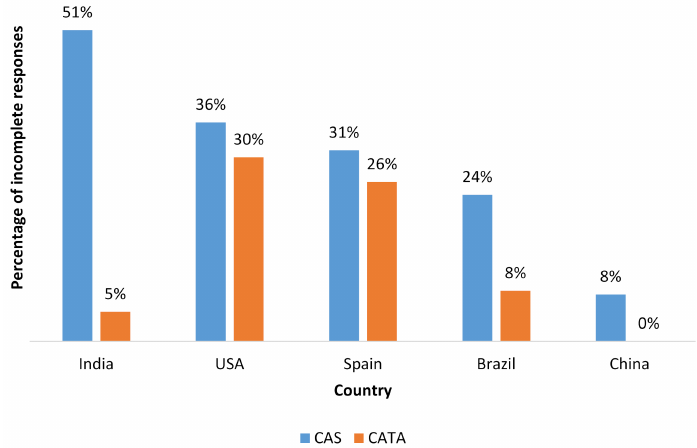
Figure 1. Percentage of incomplete responses for CAS and CATA per country. Incompete questionnaires were not accepted or used and were not counted in the approximately 200 responses received per country per questionnaire